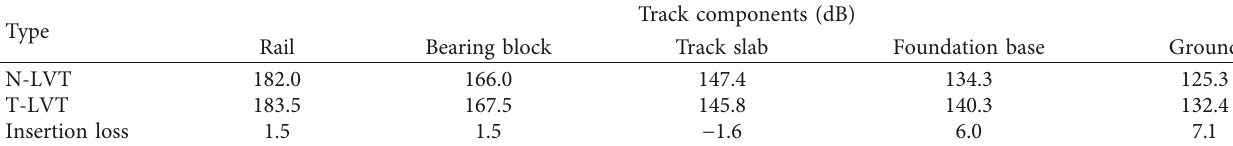
Table 2: VL z and insertion loss for each component.